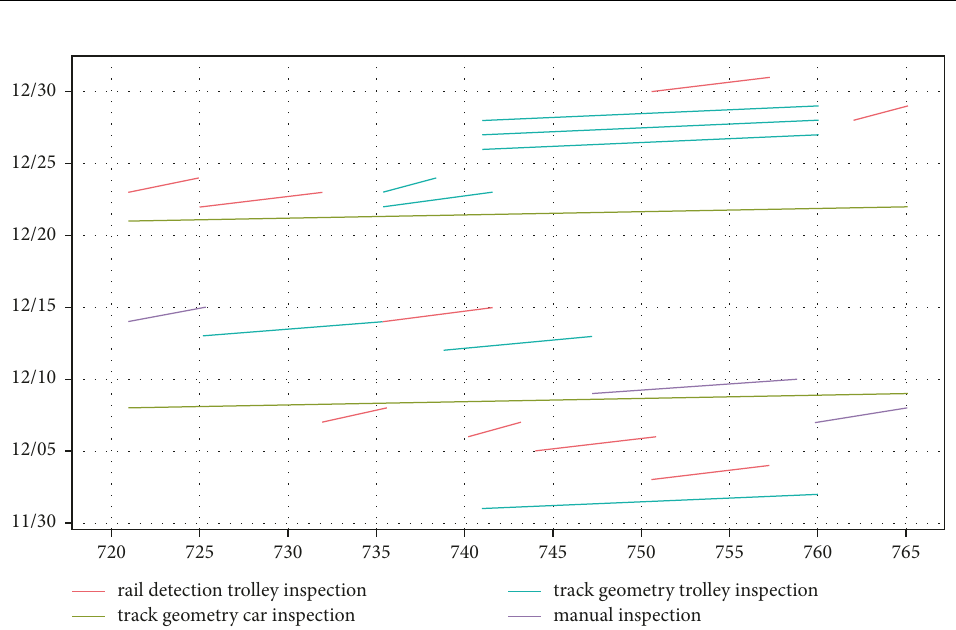
Figure 7: Actual track inspection schedule in the Lanxin